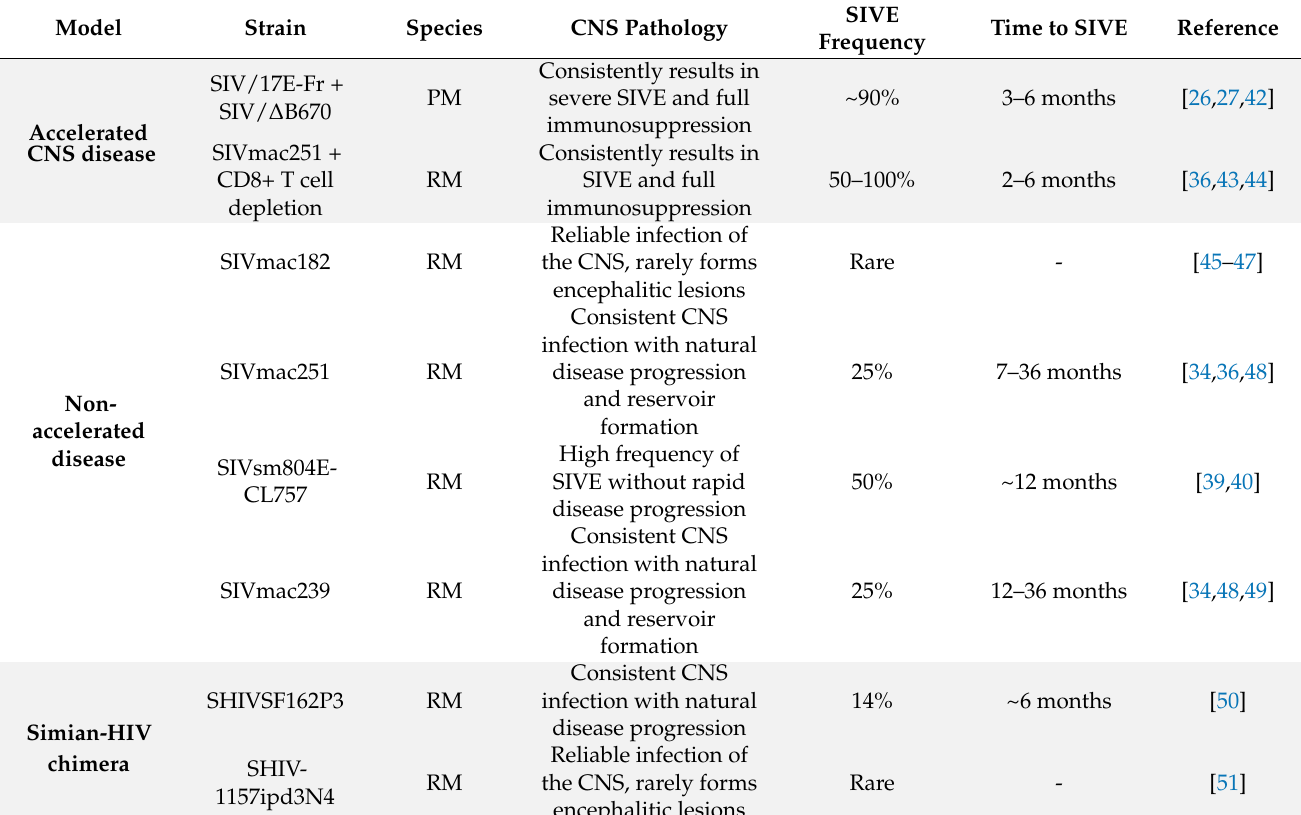
Table 1. NHP models of